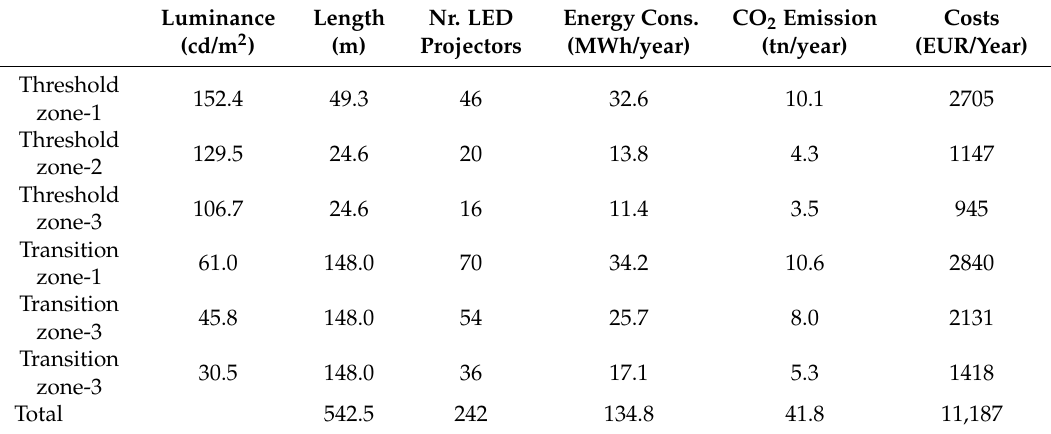
Table 5. Main parameters of lighting installation impact when maximum speed reduction is added to the actions in Table 4.